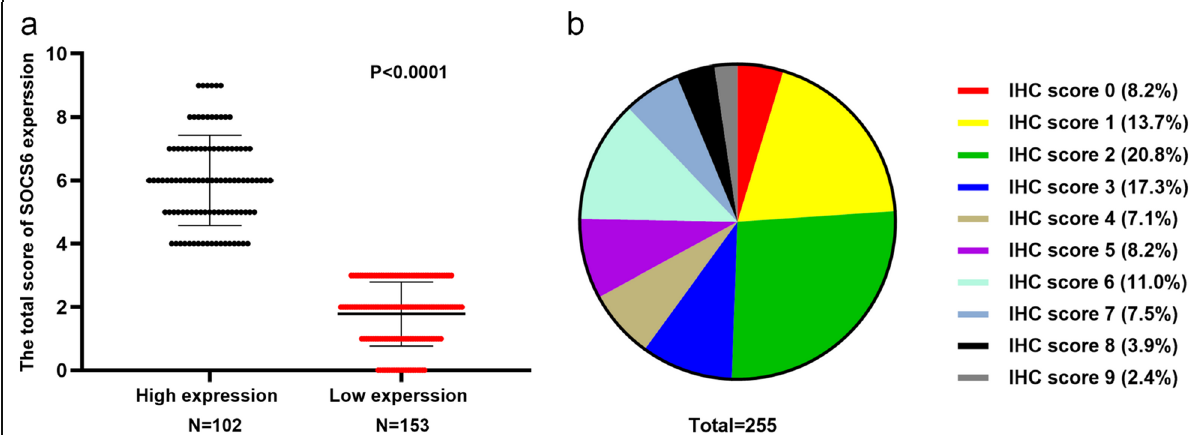
Fig. 2 Distribution of SOCS6 IHC scores among GIST patients. A High expression vs. low expression of SOCS6 among GIST patients. B Distribution of different IHC scores among the included GIST